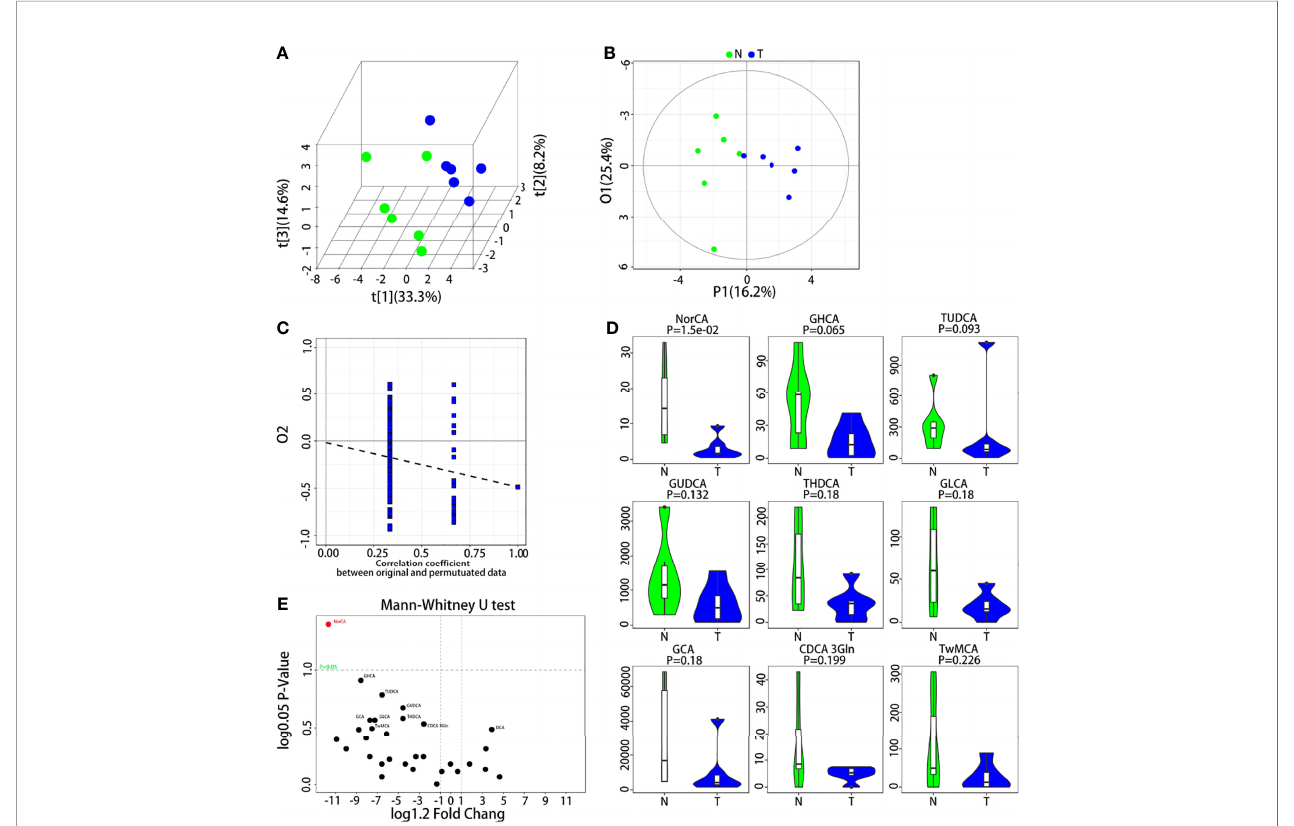
FIGURE 1 | UPLC-MS/MS analysis of BAs in the tumor and peritumoral liver tissue. (A, B) Quantitative data of the BAs in the tumor and peritumoral liver tissue were analyzed with a PLS-DA plot and OPLS-DA plot, respectively. (C) Permutation test was applied to estimate the effectiveness of the advanced model. (D) The differential BAs were examined by Mann-Whitney U test for univariate statistical analysis, and we used violin diagrams to display the top 9 representative BAs. (E) All BAs obtained through the univariate statistical analysis are